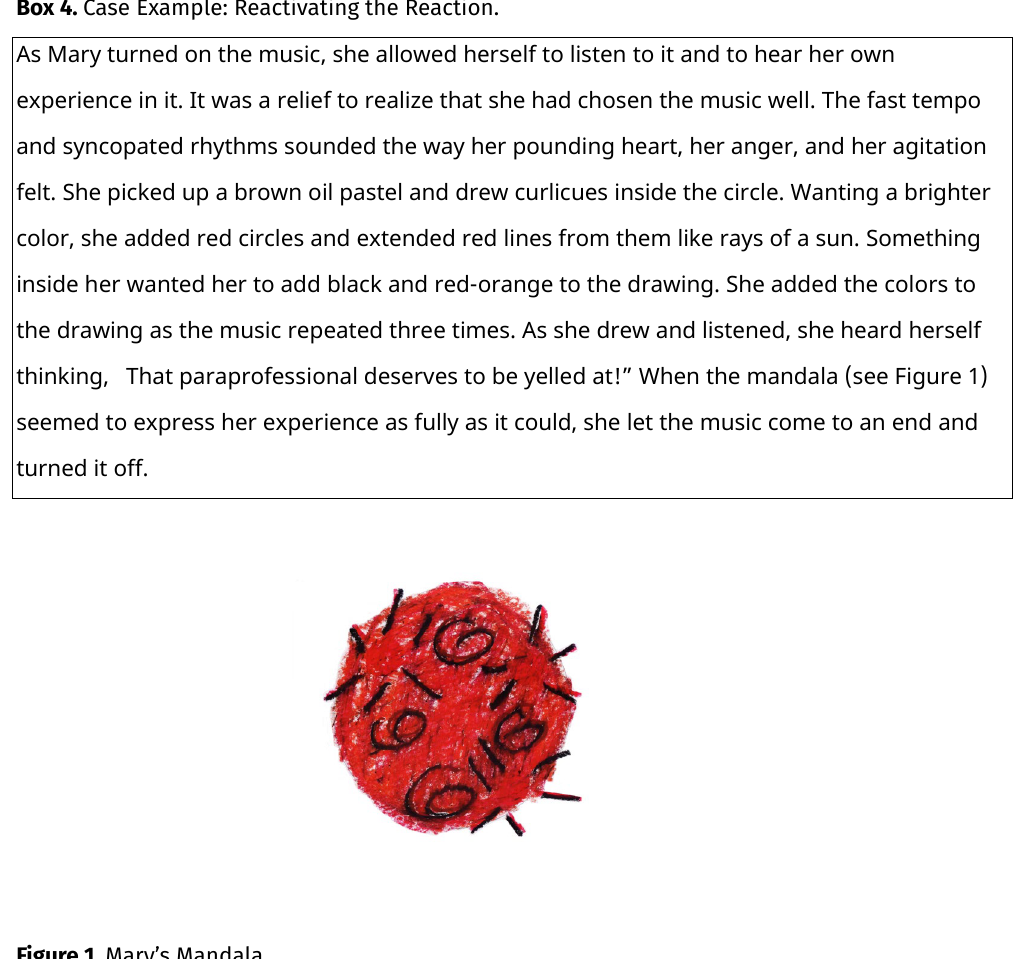
Figure 1. Mary’s